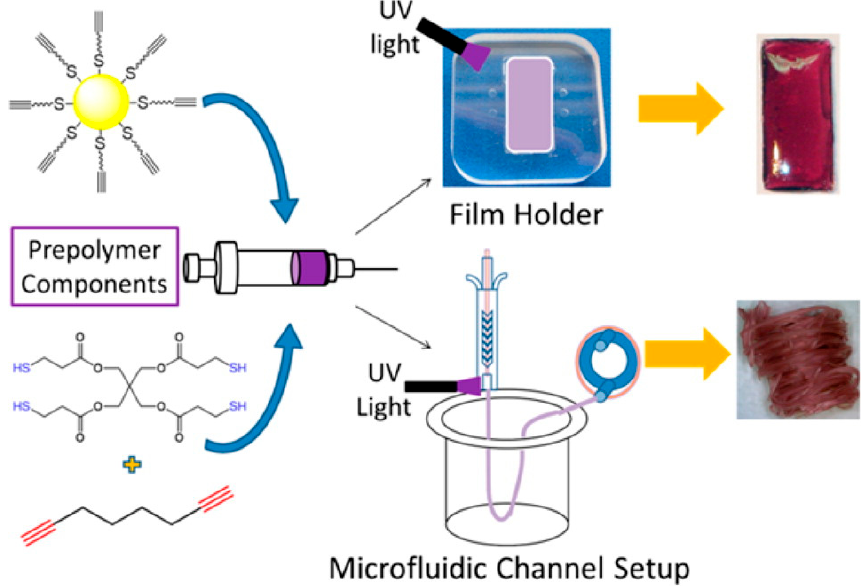
Figure 7. Fabrication of film and fiber nanocomposites of Au NPs via thiol click chemistry. Adapted with permission from [141]. Copyright © 2013 by the American Chemical Society.